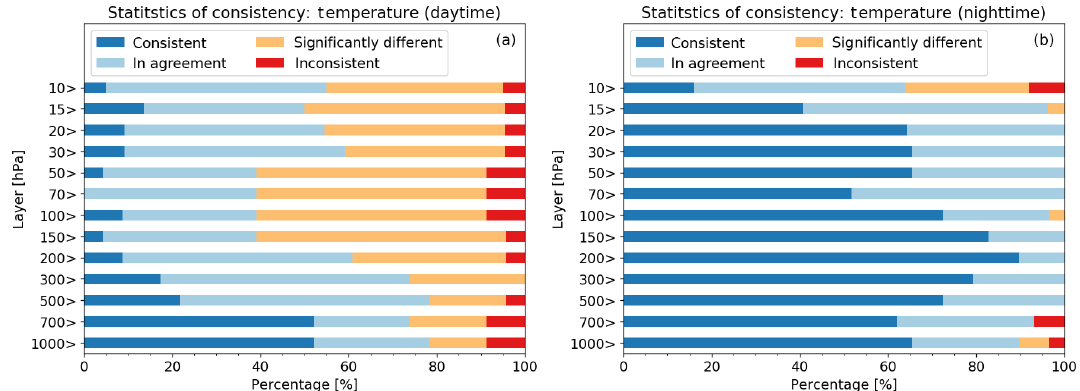
Figure 24. Percentages of consistency ranks “consistent,” “in agreement,” “significantly different”, and “inconsistent” for temperature mea- surements between RS92 GDP and RS-11G GDP in each pressure layer for daytime (a) and nighttime (b) dual